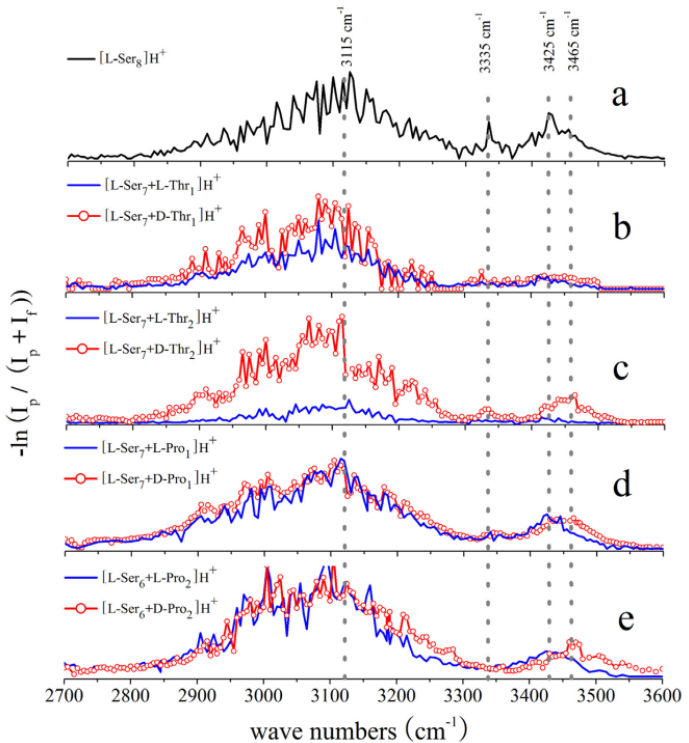
Figure 6. IRMPD spectra of ( a ) [ L -Ser 8 ]H + ; ( b ) [ L -Ser 7 + D / L -Thr 1 ]H + ; ( c ) [ L -Ser 6 + D / L -Thr 2 ]H + ; ( d ) [ L -Ser 7 + D / L -Pro 1 ]H + , and ( e ) [ L -Ser 6 + D / L -Pro 2 ]H + [41]. Reprinted with permission from Elsevier.